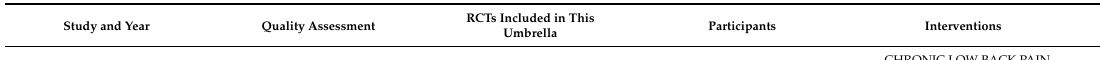
Table 4. Included reviews: